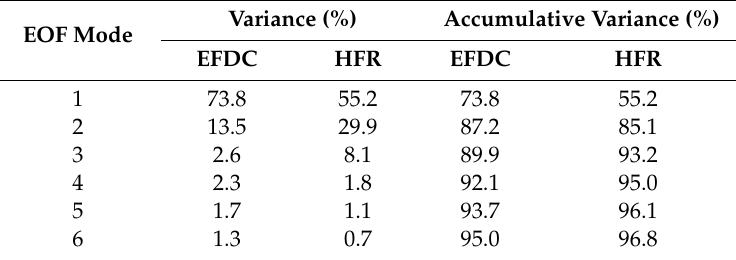
Table 3. Summary of variance for the first six EOF